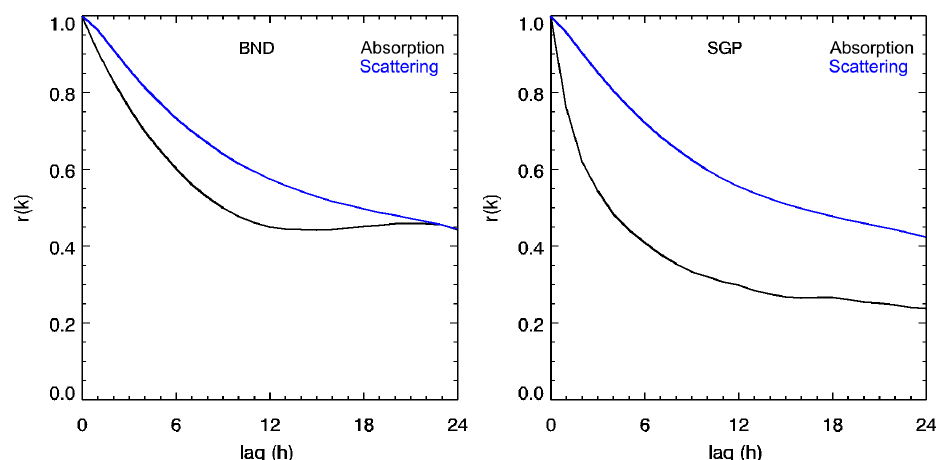
Figure 2. Correlograms for BND and SGP; wavelength = 550nm, D p <10µm, based on hourly averaged surface in situ data between 1995– 2013 (BND) and 1996–2013 (SGP). The value r(k) on the y axis represents the autocorrelation at lag time “ k